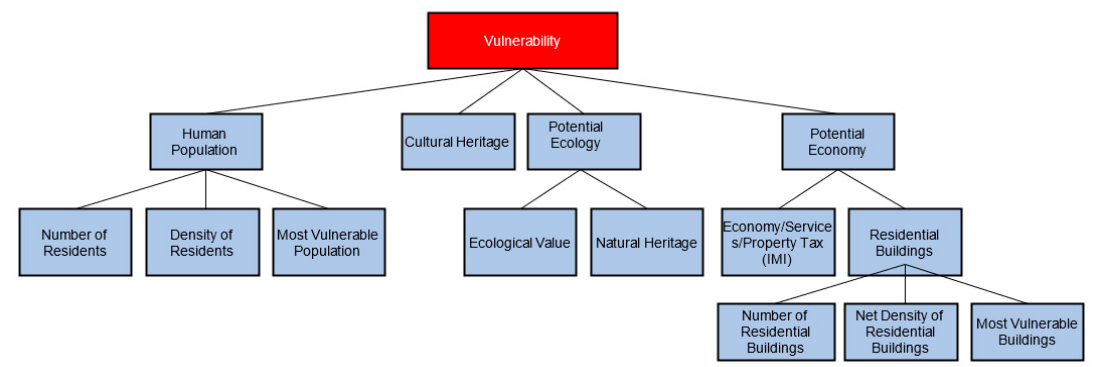
Figure 3. Vulnerability flow chart with their factors.